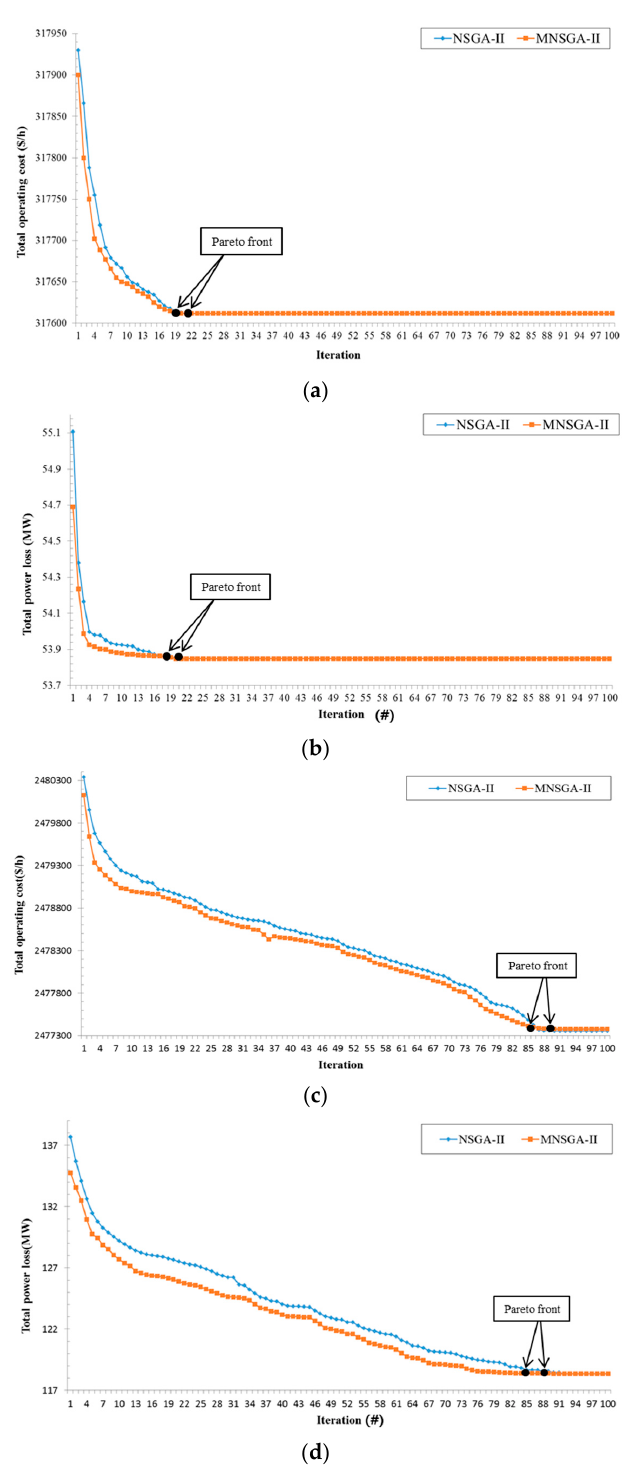
Figure 9. ( a ) Operating cost for IEEE-14 bus system; ( b ) Power loss for IEEE-14 bus system; ( c ) Operating cost for IEEE-118 bus system; ( d ) Power loss for IEEE-118 bus system. Comparison of the Pareto-solutions with NSGA-II and